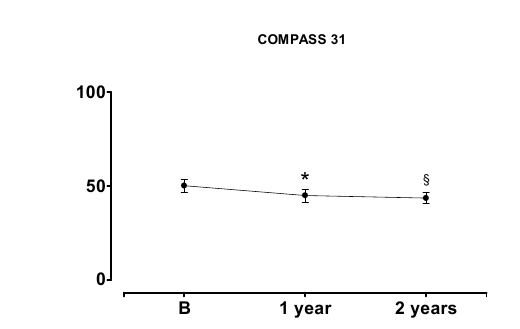
Figure 5. COMPASS 31 total score comparison between baseline and 1-year and 2-year follow-up. B indicates baseline. * indicates p < 0.05 12 months vs. baseline; § indicates p < 0.05 24 months vs. baseline. Results are expressed as mean ± SD.